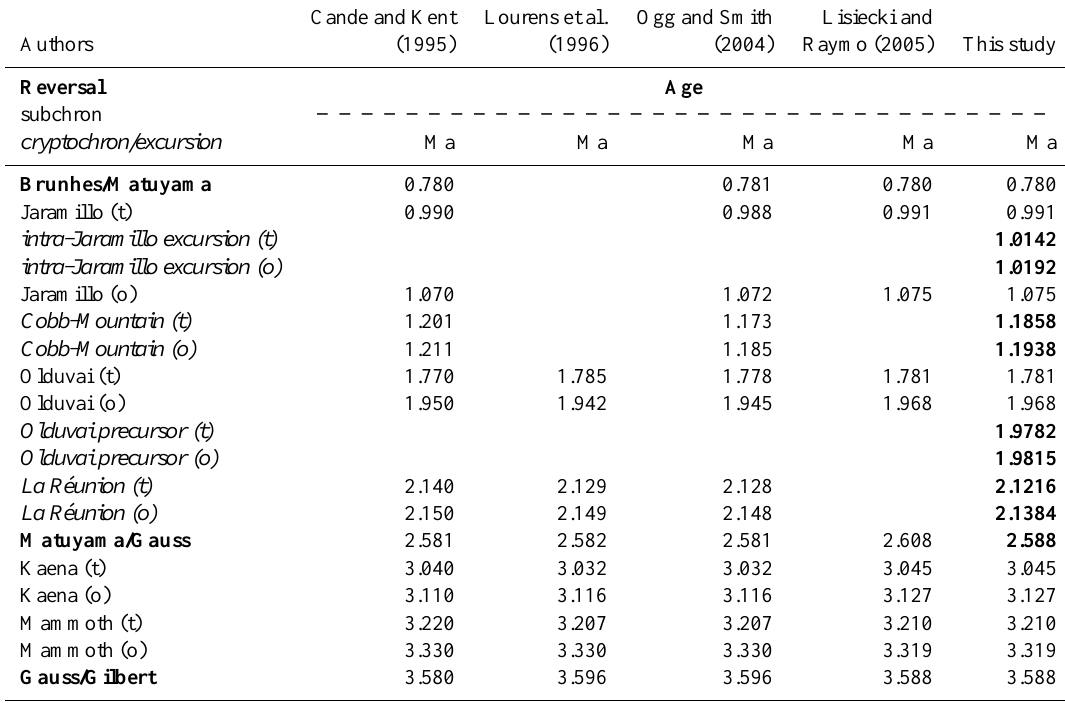
Table 1. Ages of geomagnetic reversals from various authors, listed in the first row, and as inferred from multi-proxy tuning of ICDP Site 5011-1 sediments from Lake El’gygytgyn in this study, listed in the right column. Here, bold numbers indicate new/alternative ages, otherwise ages were adopted from Lisiecki and Raymo (2005). Cande and Kent Lourens et